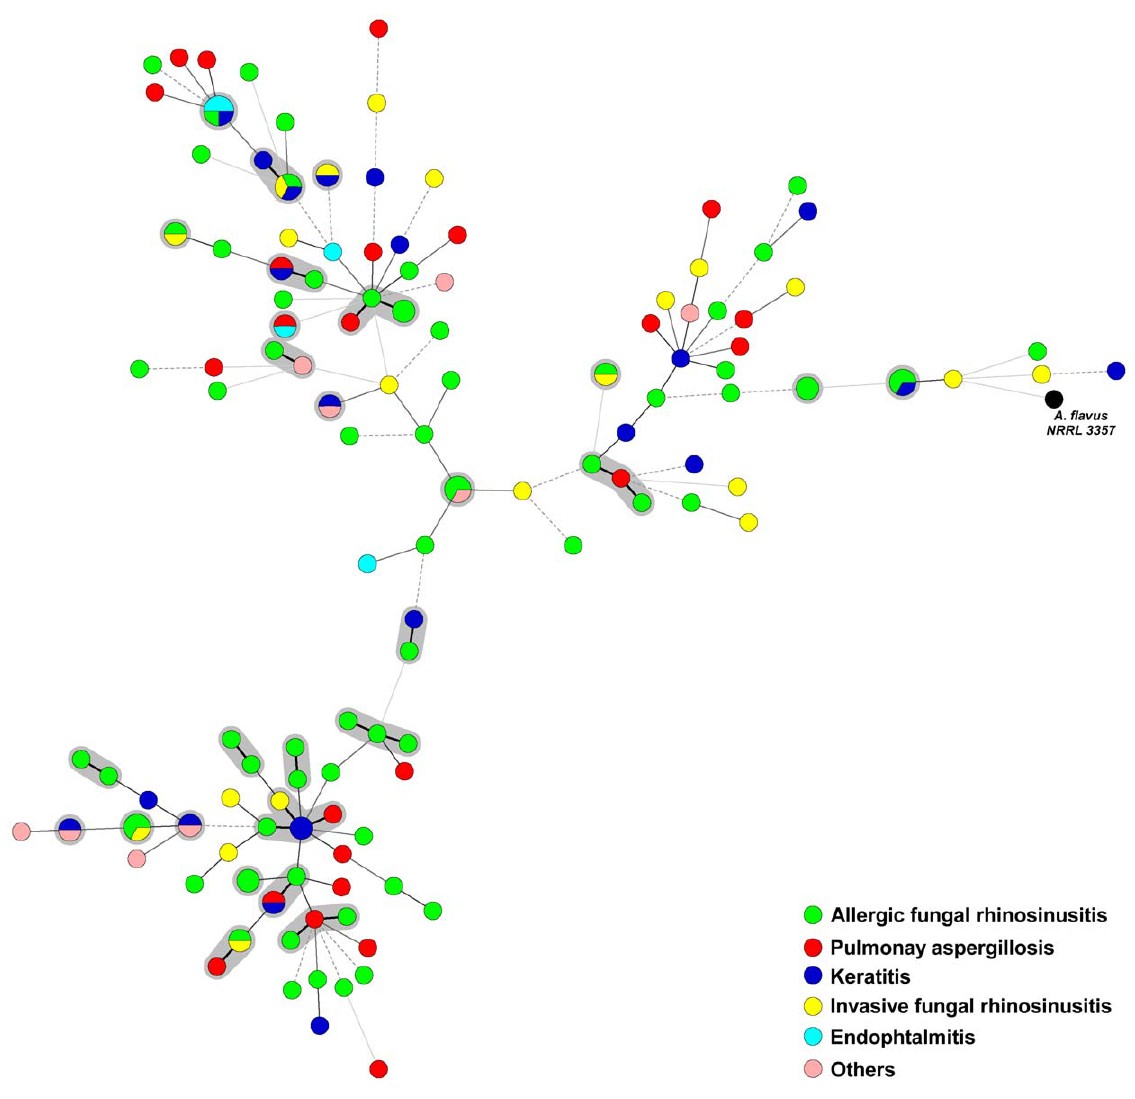
Figure 1. Graphical representation of the results. Minimum spanning tree representing the genotypic diversity of 149 clinical A. flavus isolates and a reference isolate using microsatellite typing. The MST is based on a categorical analysis of the data. Each circle represents a unique genotype. The size of the circle corresponds to the number of isolates with the same genotype. The thickness and size of the connecting bars correspond to the number of different markers between linked genotypes. The black genotype is from the reference strain A. flavus NRRL 3357. Genotypes with a shaded background contain 2 or more isolates with identical genotypes or contain genotypes that differ in only 1 microsatellite marker as the possible result of microevolutionary events and are likely to be clonally related.